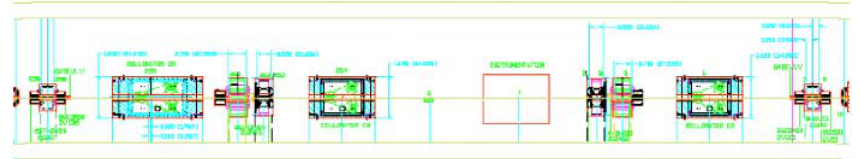
FIG. 9. (Color) Layout of the collimator straight